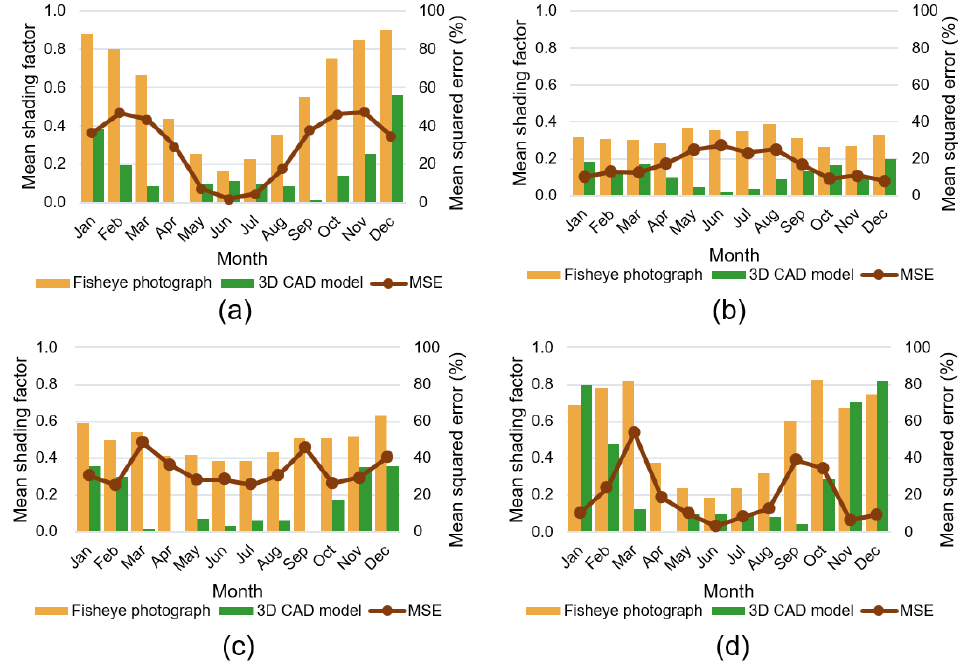
Figure 12. Mean shading factors and mean squared errors for each month at survey points ( a ) A1, ( b ) A2, ( c ) A3, and ( d ) A4.